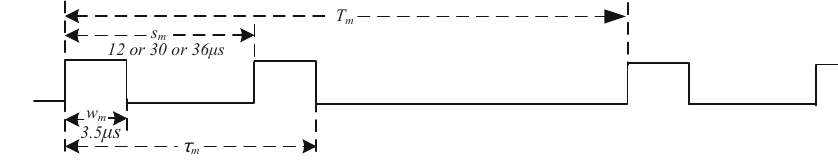
Figure 1. The basic pulse pair of DME signal. Table 1. DME pulse pair